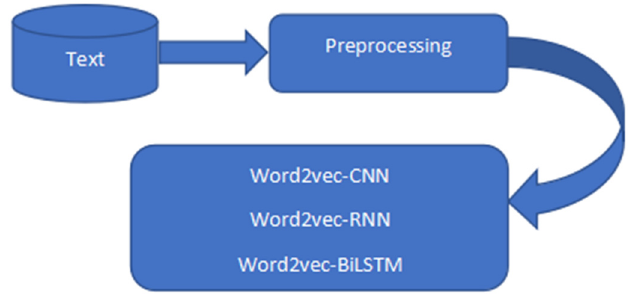
Figure 3 . CNN, RNN, BiLSTM architecture . 3.2. Bidirectional Encoder Representations from Transformers (BERT) BERT was developed in 2018 for natural language understanding tasks to assist ma- chines in comprehending the context of phrases [28]. It employs transfer learning, and the architecture is based on the transformer model. Transfer learning entails training a model for a broad task and then applying the knowledge gained to fine-tune BERT for a new task [29]. BERT has been trained on two tasks: masked language tasks, in which sentences are fed to the model and some words are masked or hidden for the model, and the model attempts to predict these hidden words, and unmasked language tasks, in which sen- tences are fed to the model and some words are masked or hidden for the model, and unmasked language tasks, in the other task is sentence prediction where pair of sentences are fed to the model each round and the model need to predict whether one sentence is followed by the other or not. BERT has been trained over a large dataset for these two tasks. The dataset contained all English Wikipedia and 11,038 books. BERT uses an en- coder from a transformer model, a type of neural network that takes a sentence as input to the model. Then each word of the sentence is tokenized, and these tokenized words are fed to the BERT model. BERT output is a vector representation for each tokenized word. Using encoders from Transformer enables BERT to have a better context understand- ing than traditional neural networks such as LSTM or RNN since the encoder process all inputs, which is the whole sentence, simultaneously so when building a context for a word, BERT will take into account the inputs before it and also the inputs after the word, while the LSTM or RNN process the input taking in account only the prior inputs, and that will be reflected on the output vector value for the word, so the word “python” in the two sentences (I just started learning Python) and (Python are found in part of Africa and Asia) would have the same vector value—and as a result the same meaning—when using LSTM or RNN; on the other hand, it would have two different vectors using BERT, so as